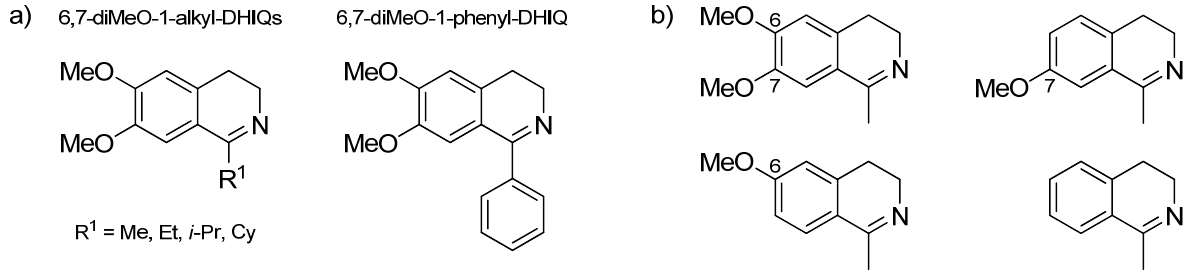
Figure 6. Examples of ( a ) 1-alkyl- and 1-aryl-DHIQs and ( b ) methoxylated derivatives of